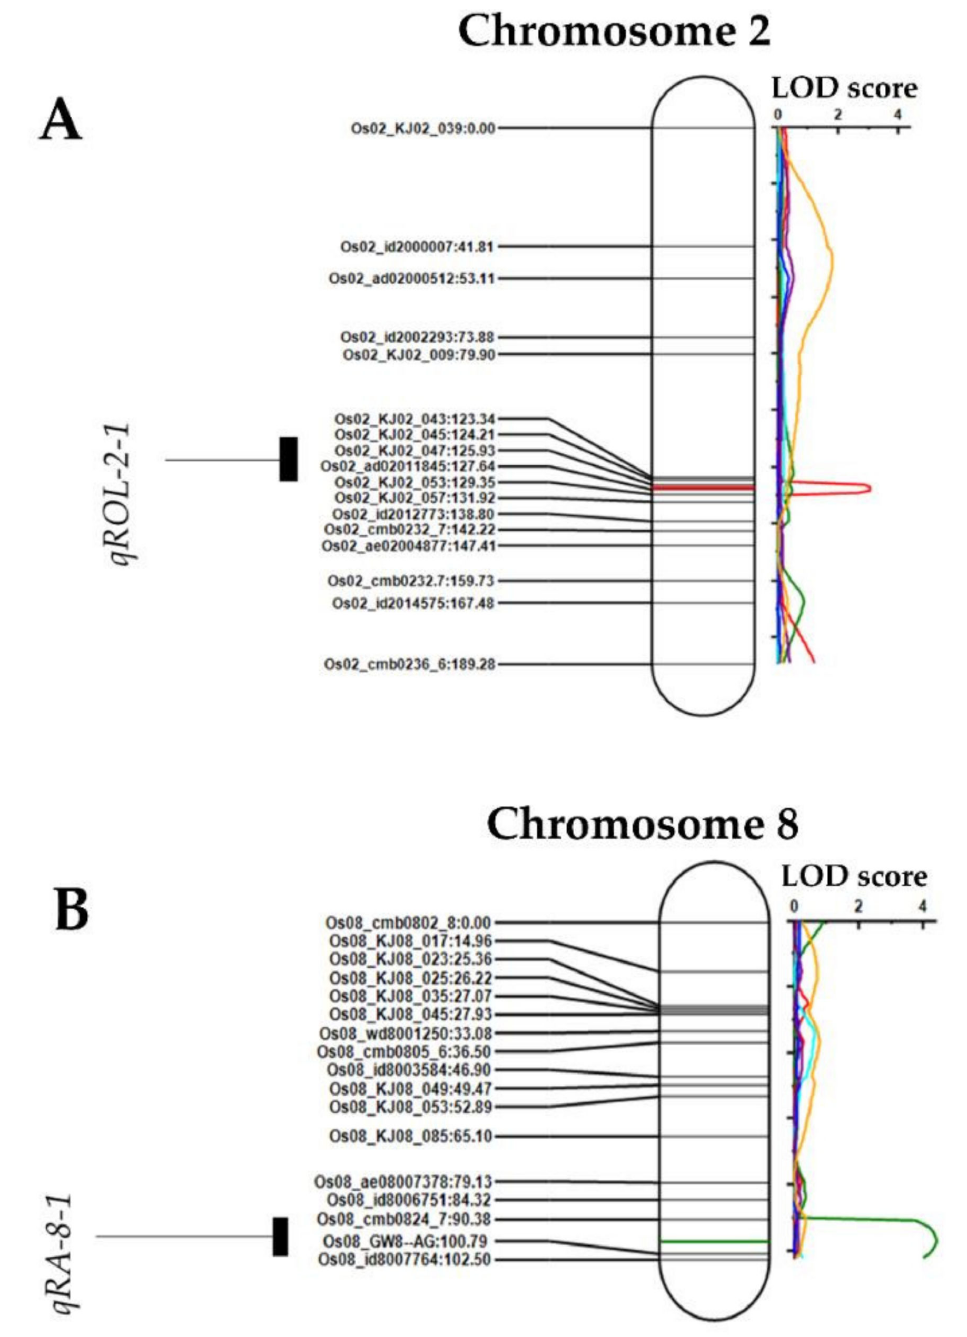
Figure 4. Linkage maps and QTLs associated with radial oxygen loss (ROL) in rice seedlings. ( A ) A unique QTL ( qROL-2-1 , 127 cM indicated by the red line inside the chromosome and the red LOD peak) associated with ROL in rice was detected on chromosome 2. ( B ) One QTL ( qRA-8-1 , 97 cM indicated by the green line inside the chromosome and the green LOD peak) associated with root area under FeS stress was mapped on chromosome